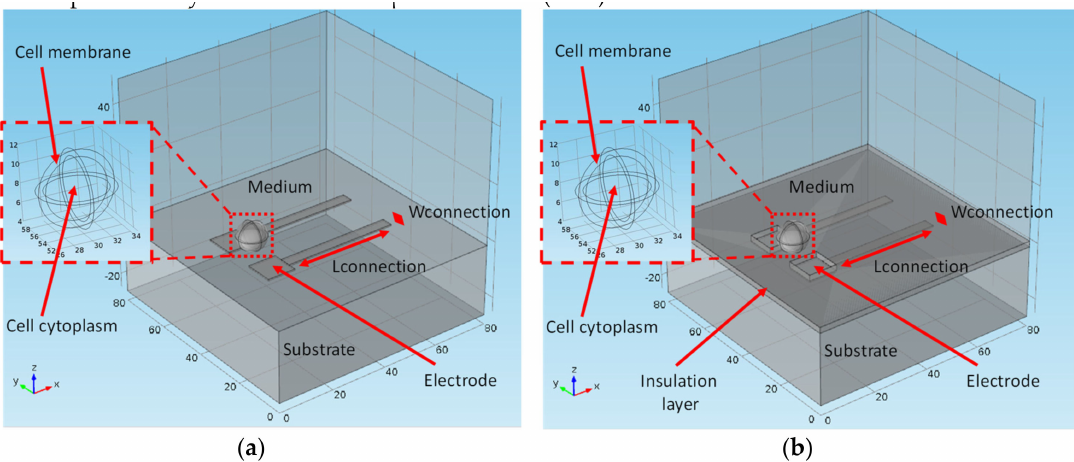
Figure A1. Simulation blocks and description of the components for the biosensor ( a ) without the insulation layer on the connection and ( b ) with the insulation layer on the connection